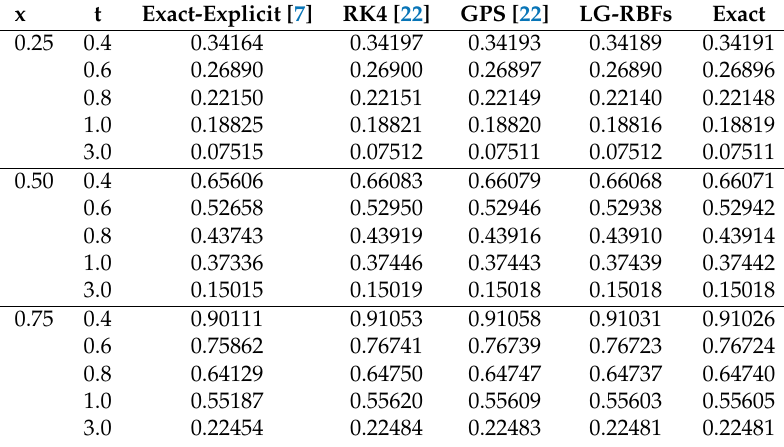
Table 3. Comparison of the approximate solutions at different final times with v = 0.01, M = 80 and ∆ t = 0.0001.